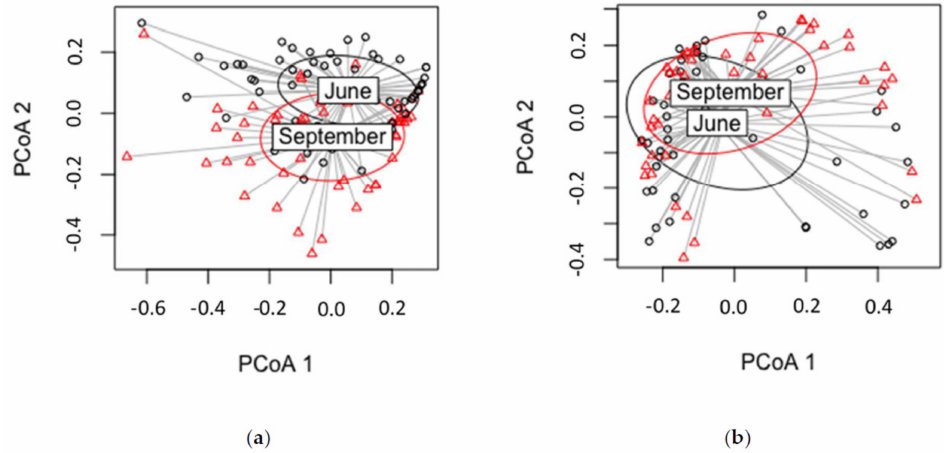
Figure 7. Dispersion of species for the isolate data ( a ) and OTUs in the HTS data; ( b ) in each sample between sampling times June (black) and September